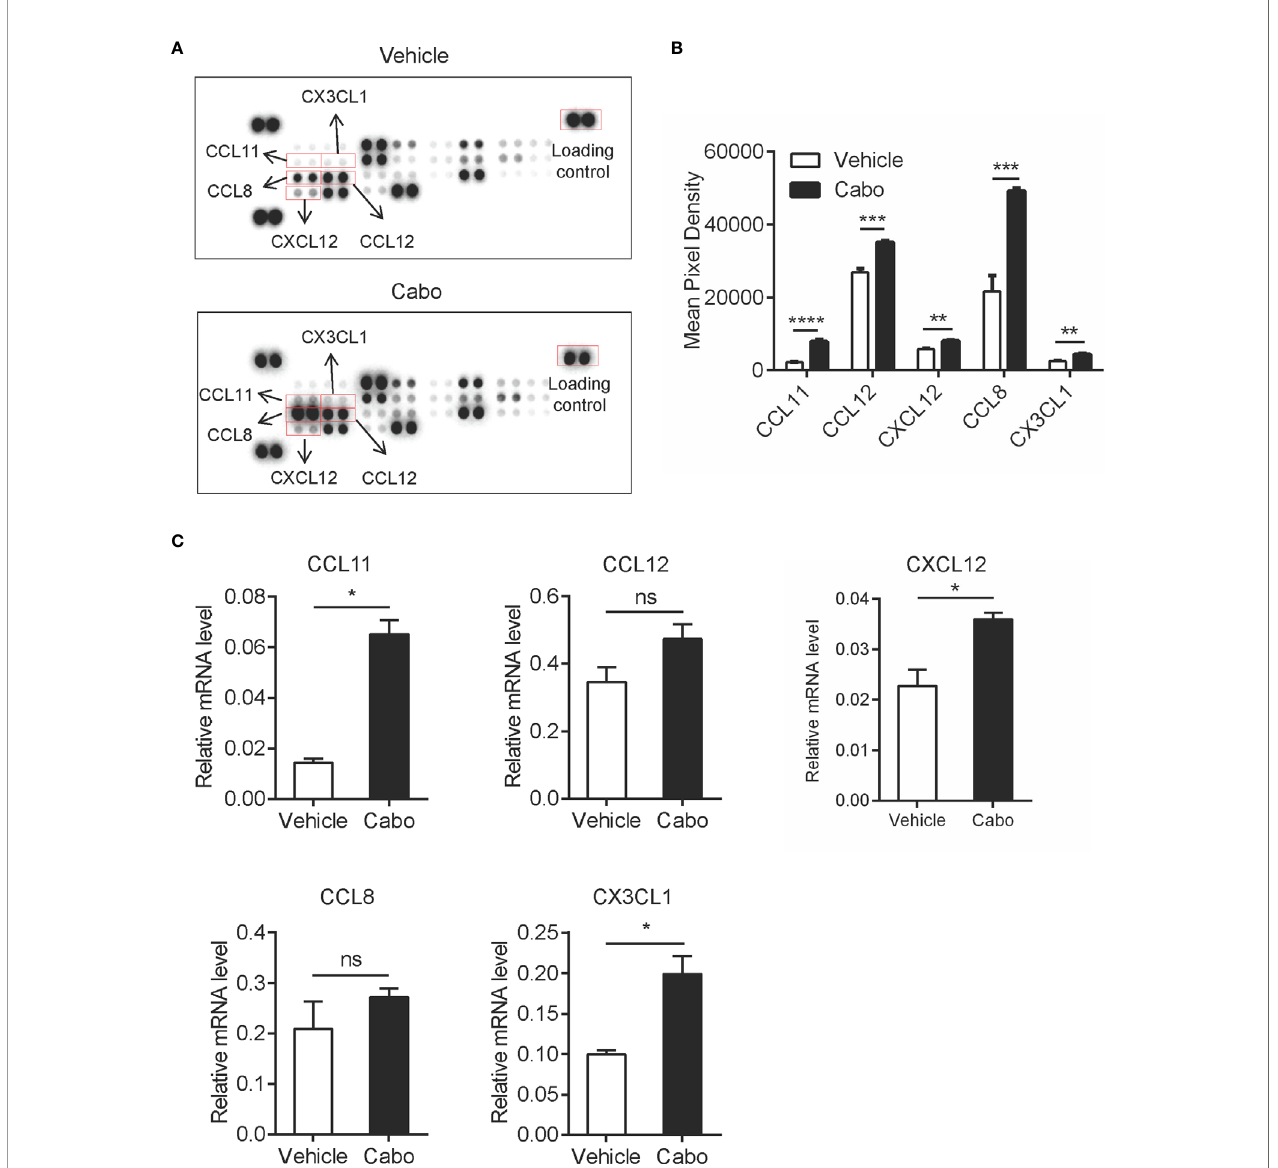
FIGURE 4 | Cabozantinib causes upregulation of chemokines in the tumor microenvironment. Mice were treated as in Figure 2A . (A, B) At the end of the experiment, total protein was extracted from tumor tissues of two random mice per group. Levels of 25 chemokines were detected using mouse chemokine antibody array kits. Chemokine expression levels are presented as arbitrary units measured by densitometry (n=2, biological replicate). Representative fi lms (A) and quantitative results (B) of chemokines by chemokine array analysis. (C) RNA was prepared from snap-frozen tumor tissue (n=3, biological replicate). Relative mRNA expression of chemokines was determined by qRT-PCR. Data are shown as the mean values ± SEM. * P <0.05, ** P <0.01, *** P <0.001, **** P <0.0001 by unpaired t-test; ns, not signi fi